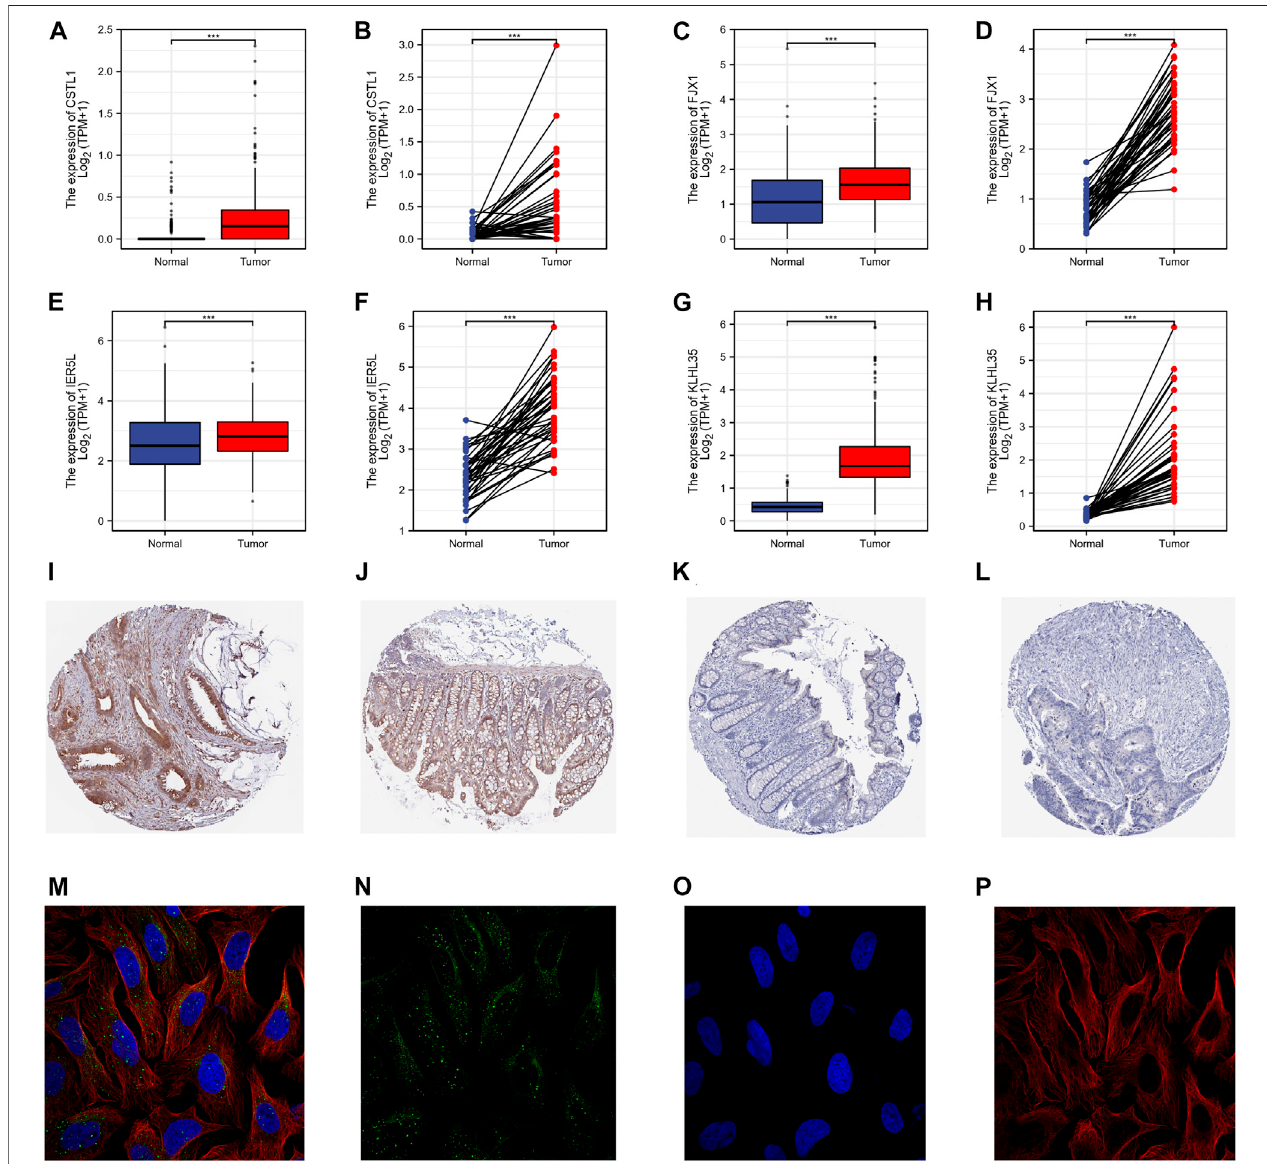
FIGURE 5 | Gene transcription and protein expression levels. (A – H) The Mann-Whitney U test (Wilcoxon rank-sum test) for unpaired samples. The expression of CSTL1, FJX1, IER5L, and KLHL35 in tumor tissue was higher than that in normal tissue. (I – L) The immunohistochemical staining of the HPA database showed that the strong positive expression of FJX1 in colon cancer tissues was signi fi cantly different from that in normal colon tissues, while the protein level of KLHL35 was not signi fi cantly different. (M – P) The sub-localization of FJX1 in vesicles in the cells from the HPA database.